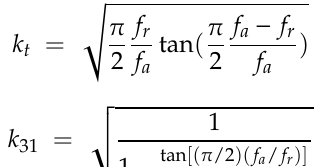
Table 1. Comparison of the properties of previously reported ceramic/single crystals.